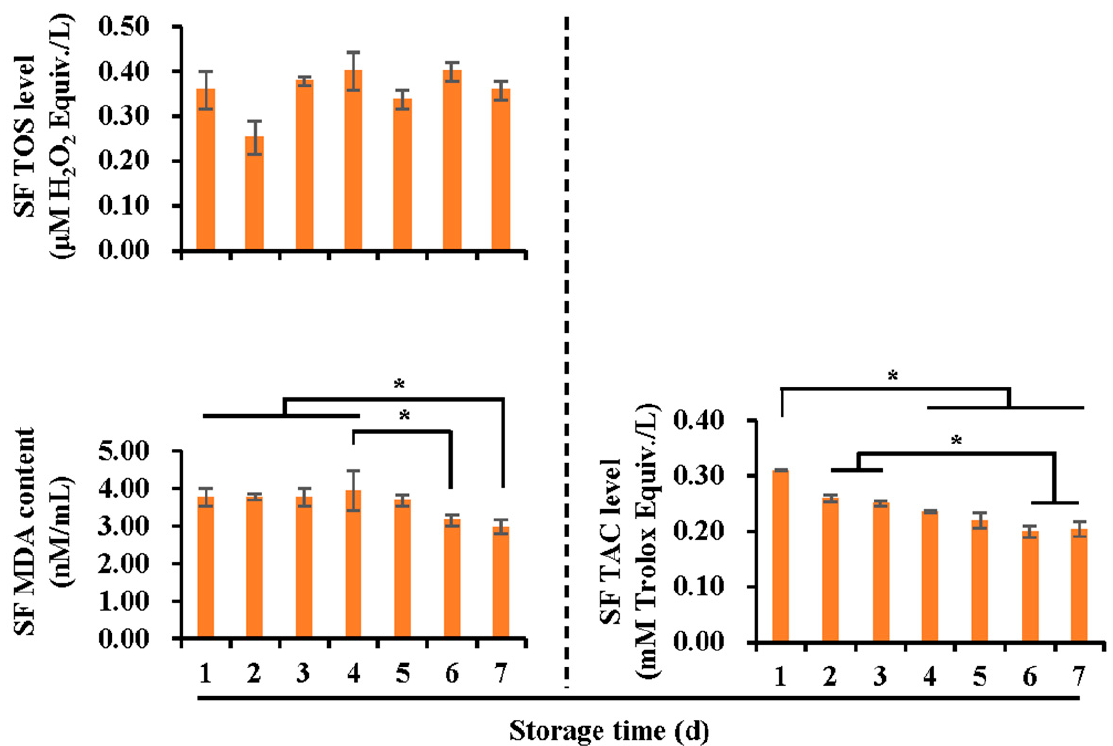
Figure 1. Histograms showing antioxidant and oxidant levels in SF (sperm surrounding fluid), according to storage time (days). TOS: total oxidant status, MDA: malondialchehyche, TAC: total antioxidant capacity. Data were pooled from 18 Duroc boars and are expressed as the mean ± SEM. * indicates differences among groups, p < 0.05.